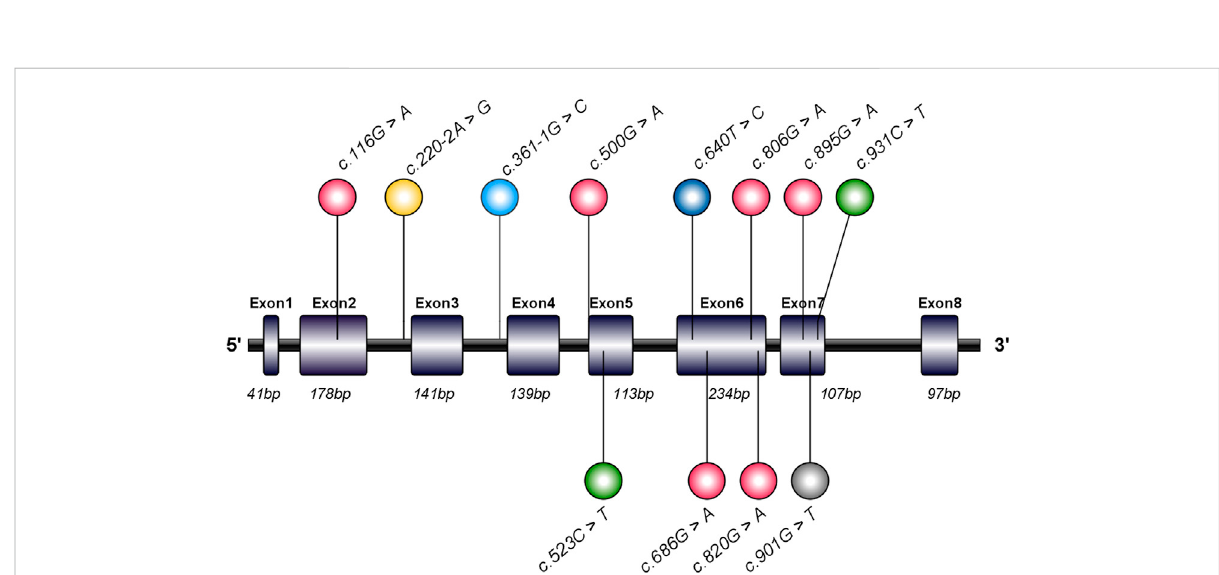
FIGURE 4 Curve fi tting of serum triglyceride (TG) changing trend with age in patients with transient infantile hypertriglyceridemia (HTGTI). Restricted cubic spline (RCS) with four knots was used to model the association of serum TG with age. The curve shows a good simulation of the correlation between this binary ( p < 0.001). The TG level decreased sharply from the peak point in the early age of infants to the normal value (1.7 mmol/L) but rebounded during follow-up, especially after approximately 50 months old.